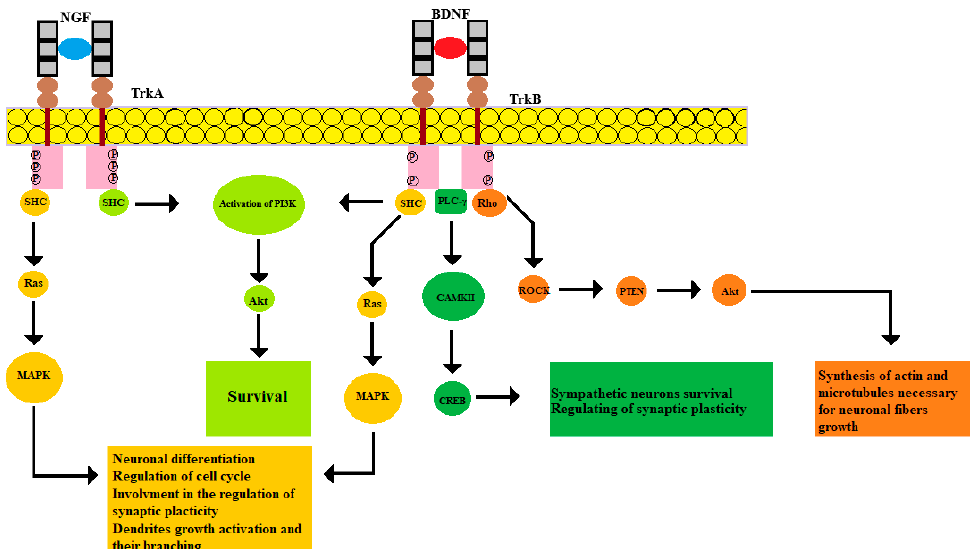
Figure 1. NGF and TrkA binding, just as BDNF and TrkB, leads to dimerization and autophosphorylation of receptors at tyrosine residues. This activates adapter proteins such as SHC, GRB2, GAB1, which ultimately lead to activation of the main signaling pathways. SHC activation involves the Ras-MAPK signaling system, activation of GRB2 and GAB1 mediates signaling along the PI3K-Akt pathway. In addition, phosphorylation of the tyrosine residue 816 TrkB initiates PLC- γ activity, whereby the transcription factor CREB is phosphorylated by CAMKII. Moreover, the signaling that originates from TrkB can activate the Rho family, which leads to the activation of the Rho-associated protein kinase (ROCK), which subsequently leads to activation of the Akt